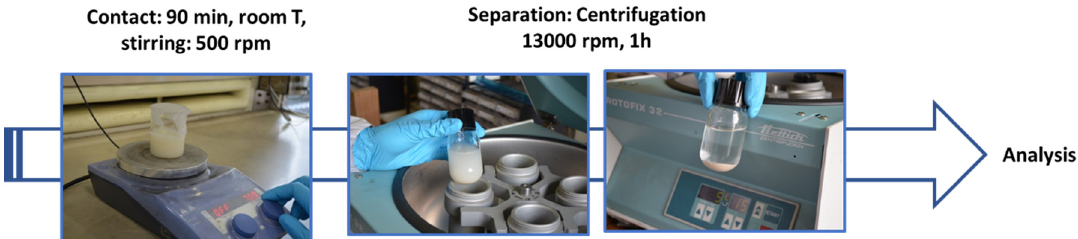
Figure 1. Procedure of the capture and release processes.